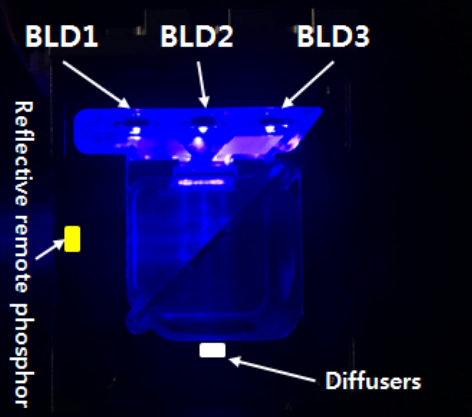
Figure 11. Bidirectional blue laser white light source module with the final designed dichroic filter applied: ( a ) phosphor white light path; ( b ) transmitted blue laser beam path.